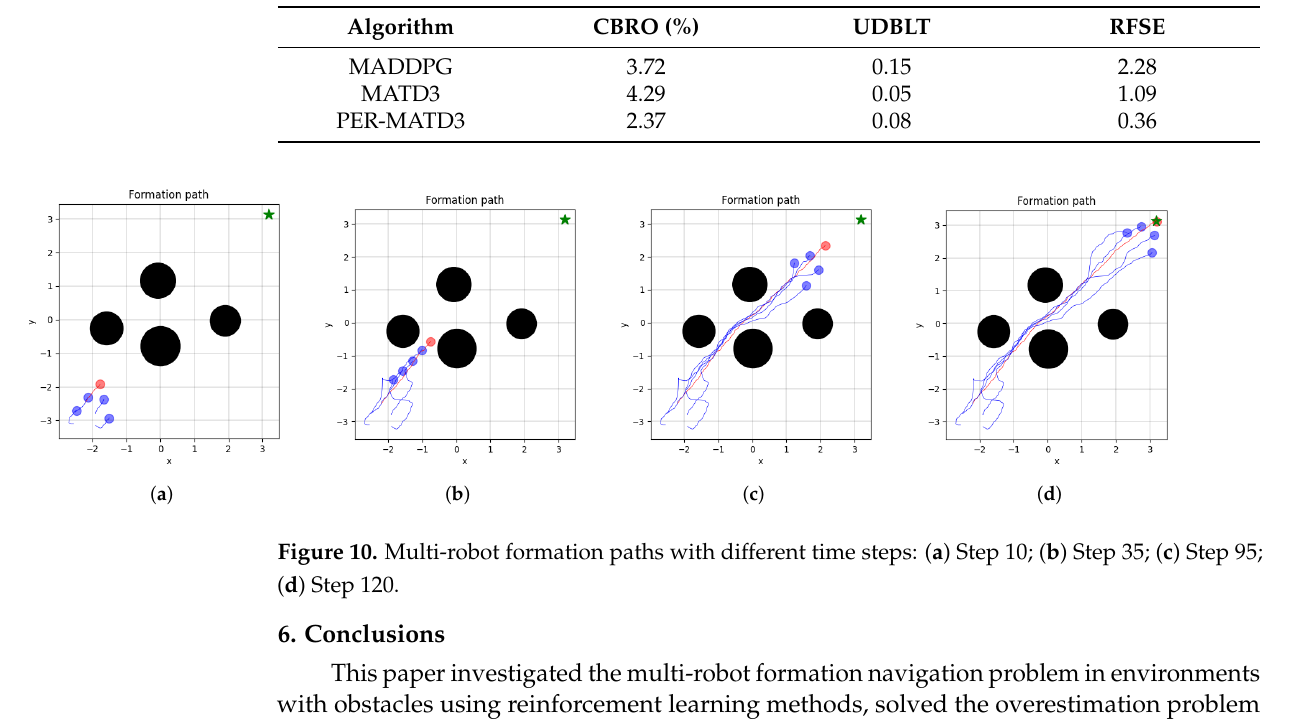
Table 1. Detailed comparison of experimental results.